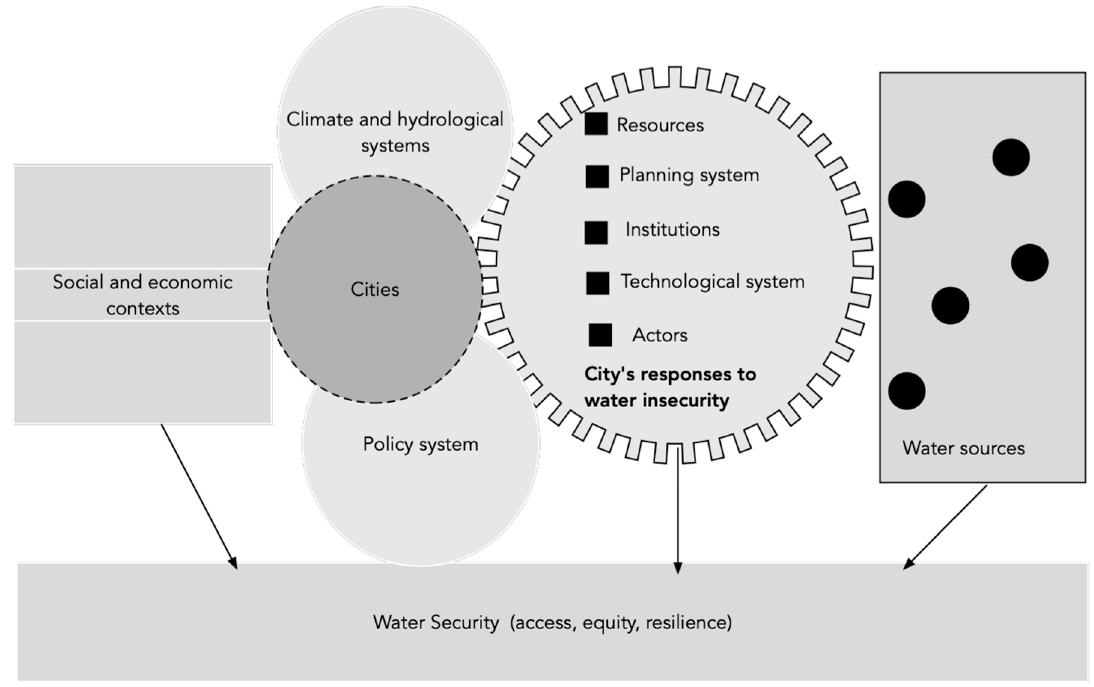
Figure 1. A Conceptual overview of cities’ struggle for access to water.